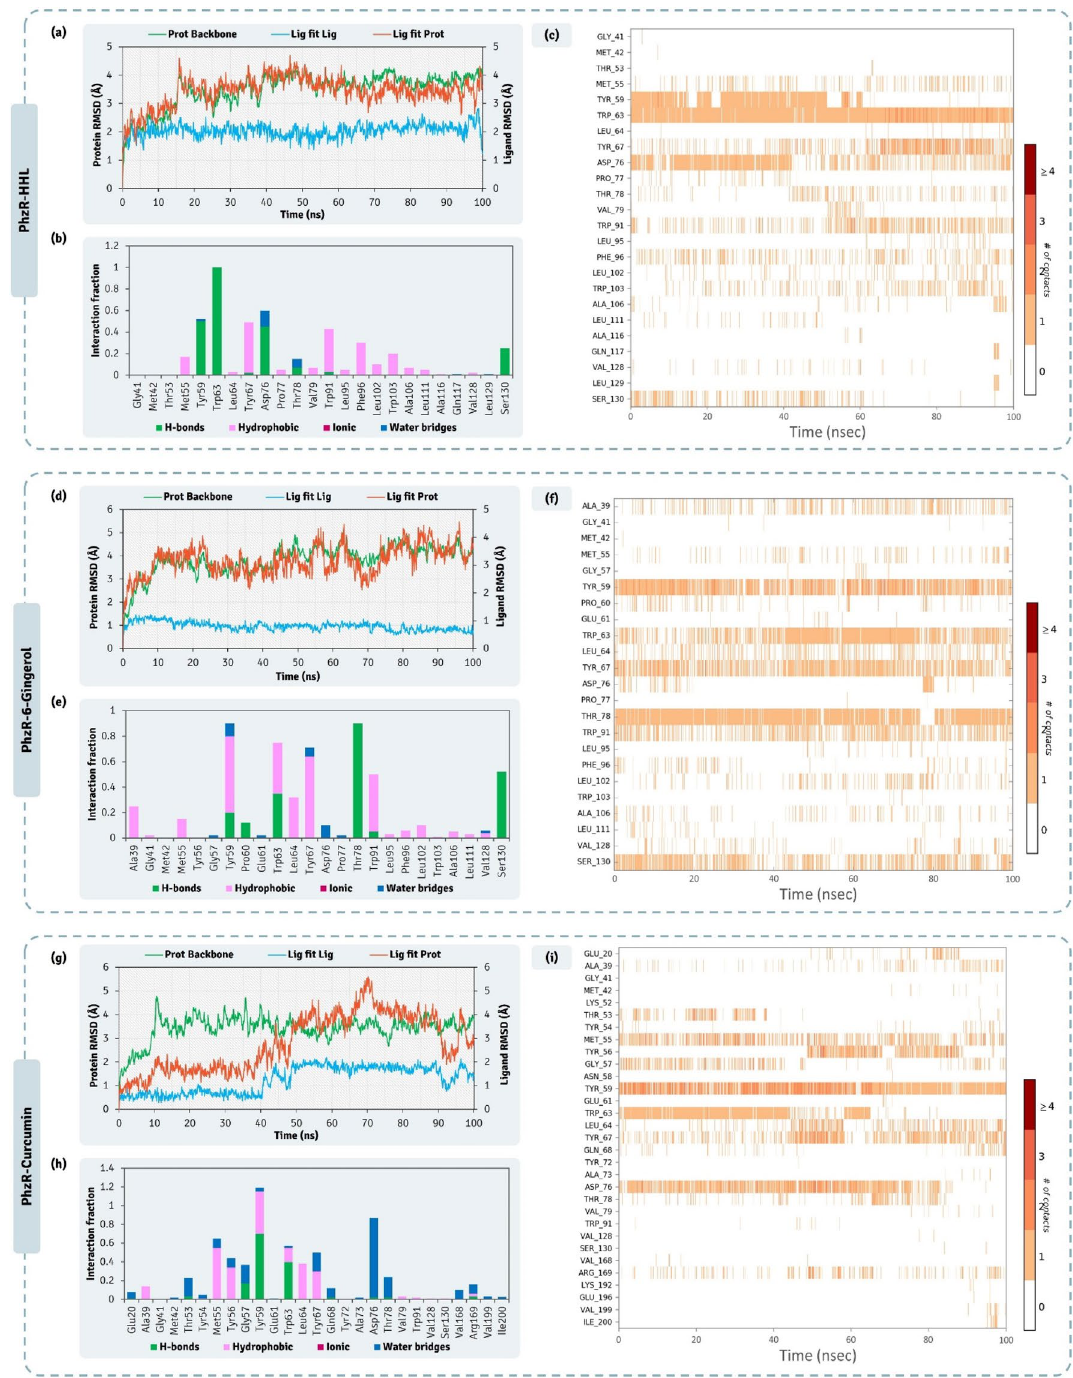
Figure 8. 100 ns MD simulation trajectory representing the RMSD assessment, ligand-receptor interaction profile and ligand-receptor interaction timeline for PhzR-HHL, PhzR-6-Gingerol, and PhzR-Curcumin